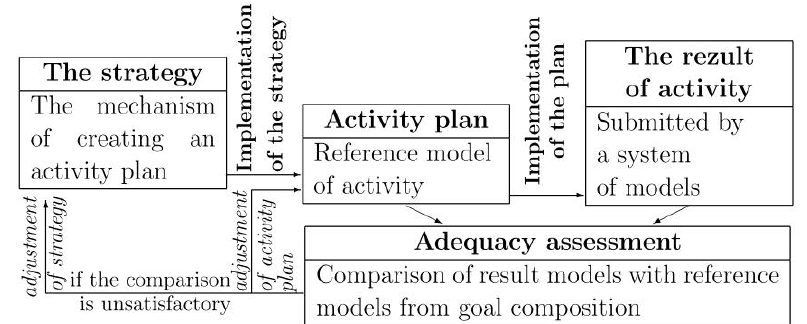
Fig. 1. Description of a planning